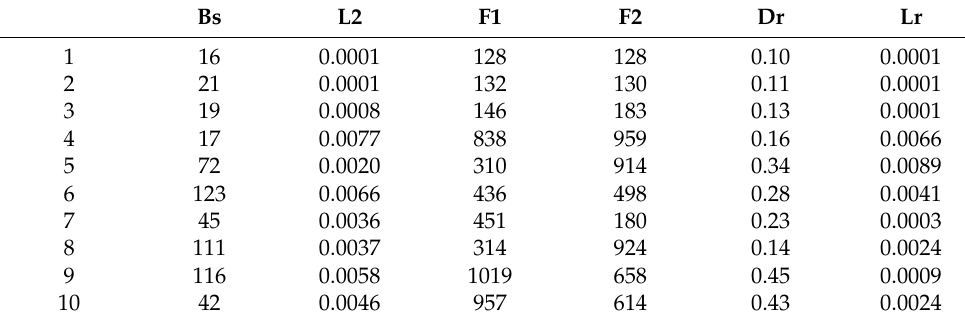
Table 13. Positions of individuals of HSSA in the experiment on MNIST.